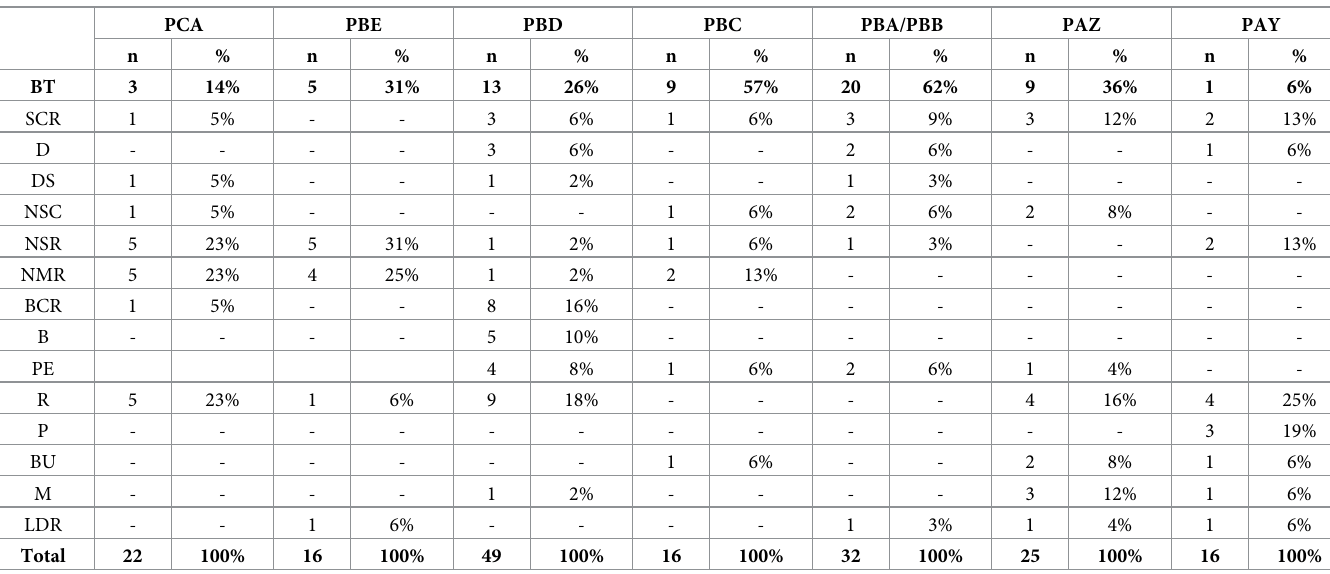
Table 5. Categories of tools identified at